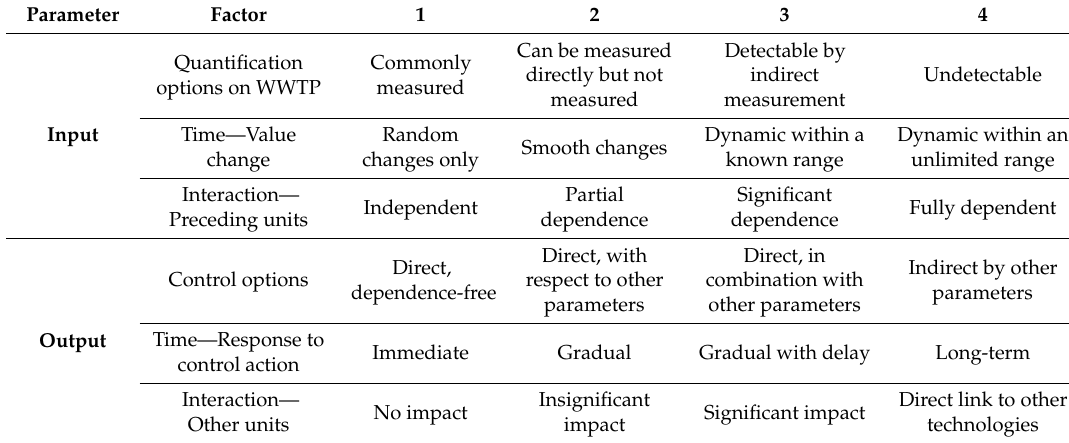
Table 6. Assessment criteria.